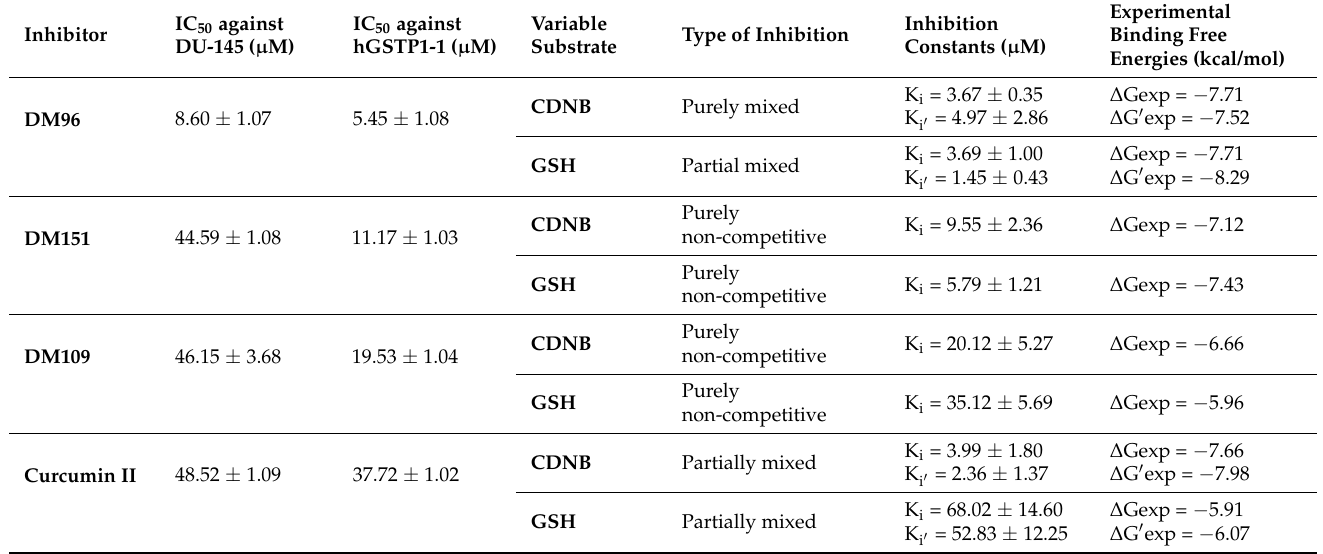
Figure 2. Concentration–response curves for the determination of the IC 50 values of the most potent inhibitors DM96, DM109, DM151, and DMC against hGSTP1-1. Table 2. Inhibition constants and IC 50 values obtained by kinetic inhibition and cytotoxicity studies of the most potent inhibitors DM96, DM151, DM109, and Curcumin II. The in-silico -determined binding free energies (kcal/mol) are also included.